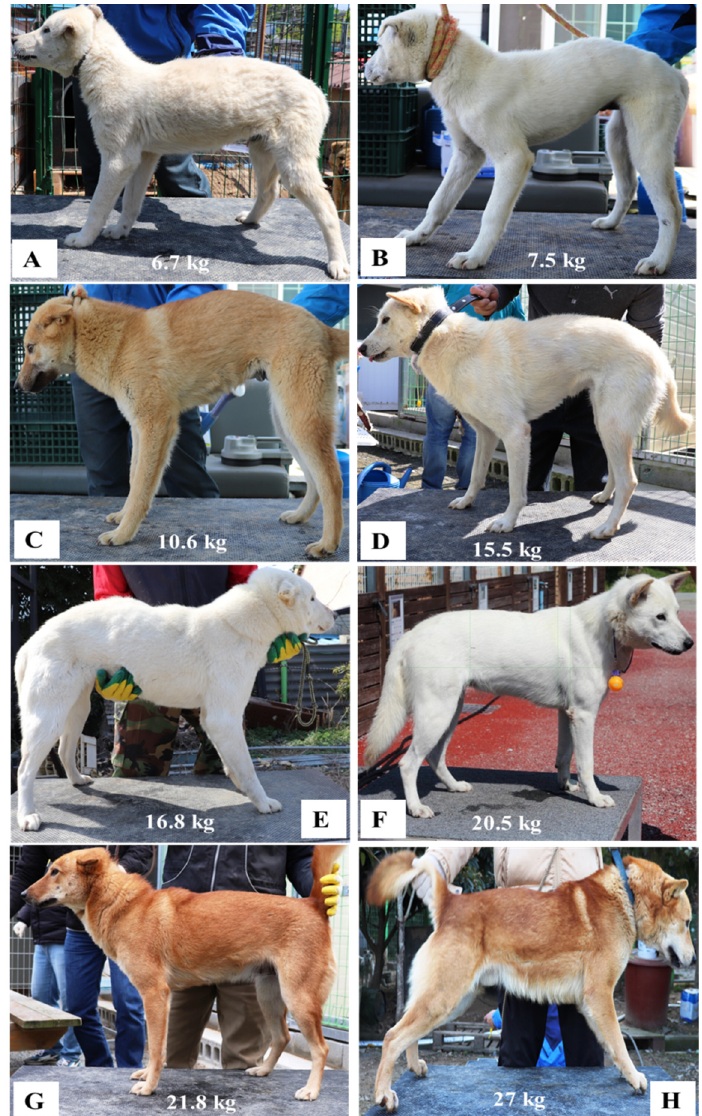
Figure 1. The phenotypic variation of Jindo dog. ( A ). Male Jindo dog with height 35.5 cm, length